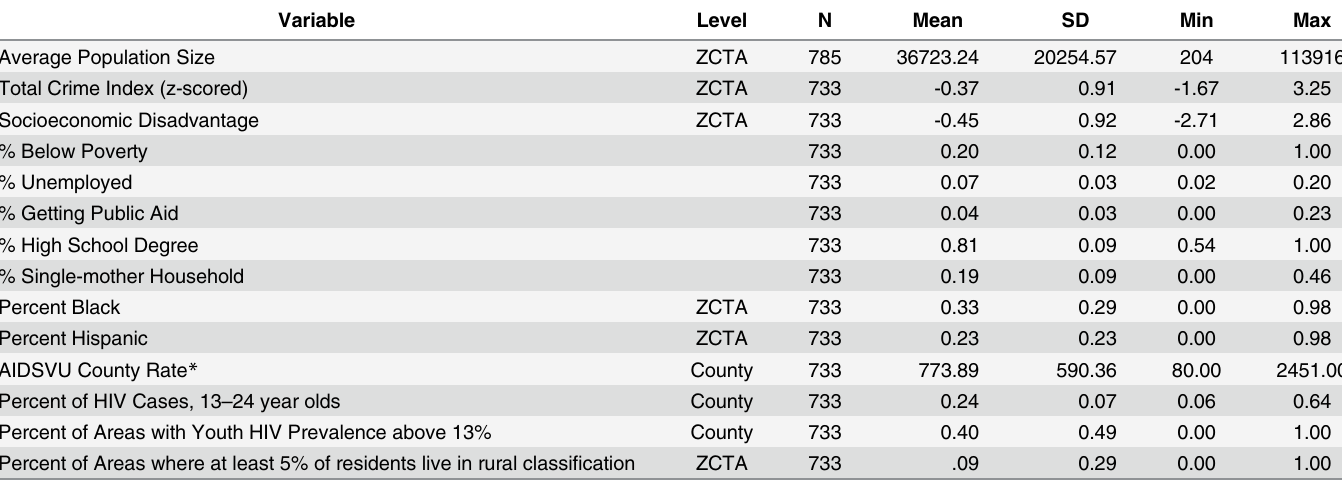
Table 2. Description of ZCTA- and County-Level Derived Structural-Level Characteristics. Variable